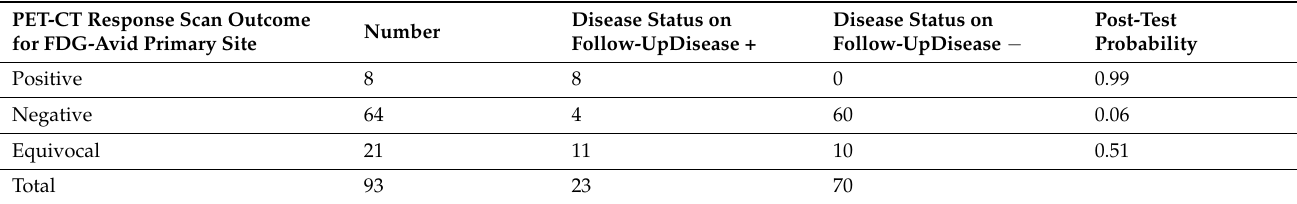
Table 3. Primary tumour response ( n = 93).